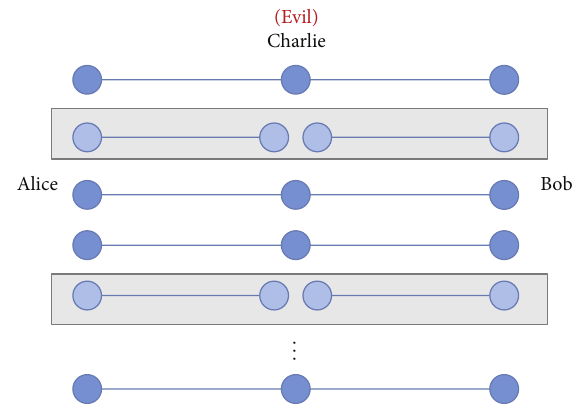
Figure 11: The scenario of participant attack in which Charlie (controller) inserts his EPR pairs to replace GHZ states.